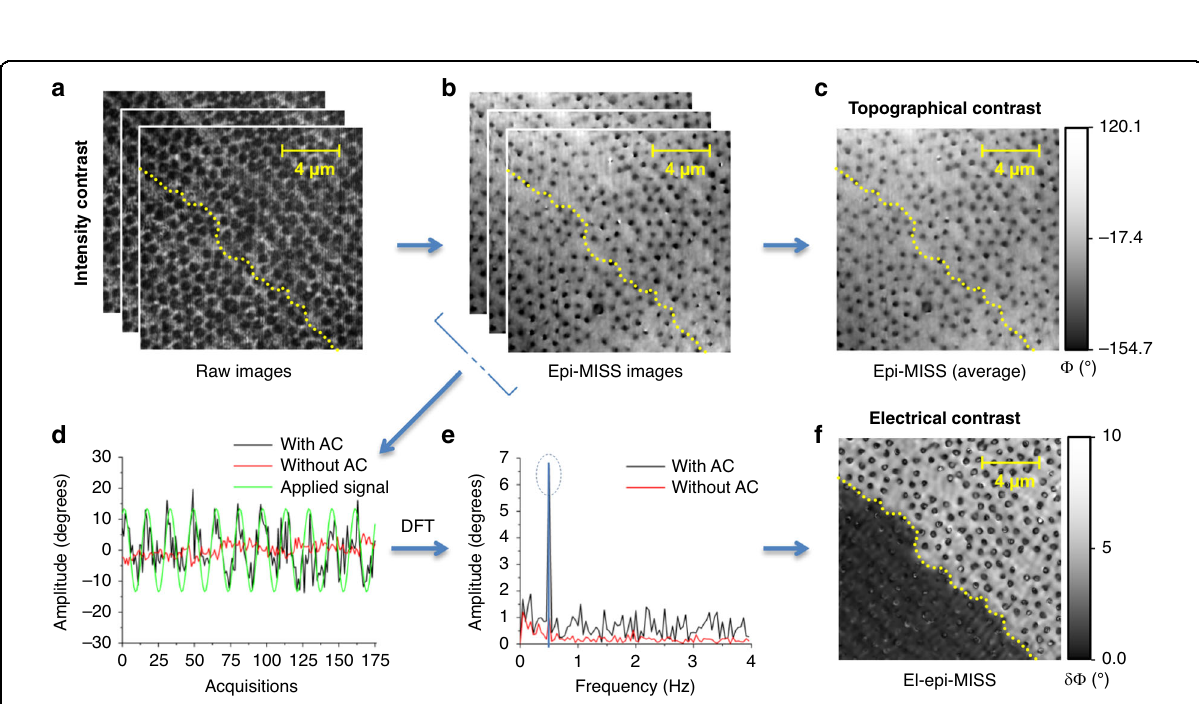
Fig. 3 Data processing work fl ow. a Acquired raw images (interferograms) at distinct time points. b Reconstructed phase maps (epi-MISS images) at distinct time points. c 2D phase map averaged over 176 frames (epi-MISS). d Time series of the phase variation (for one point in the fi eld of view) upon AC electrical actuation at 0.5 Hz (black) and without AC (red); the actuation signal is depicted in green. e Frequency spectra derived from individual pixels time series in ( d ). f 2D map of the optical phase modulation amplitude, δΦ ( ω AC , x, y ), derived from the bandpassing signal at approximately 0.5 Hz (el-epi-MISS); the dotted yellow line indicates the polydimethylsiloxane (PDMS) layer delimiting the electrochemical cell; due to its transparency and isolator nature, the PDMS layer is only visible in the map with electrical